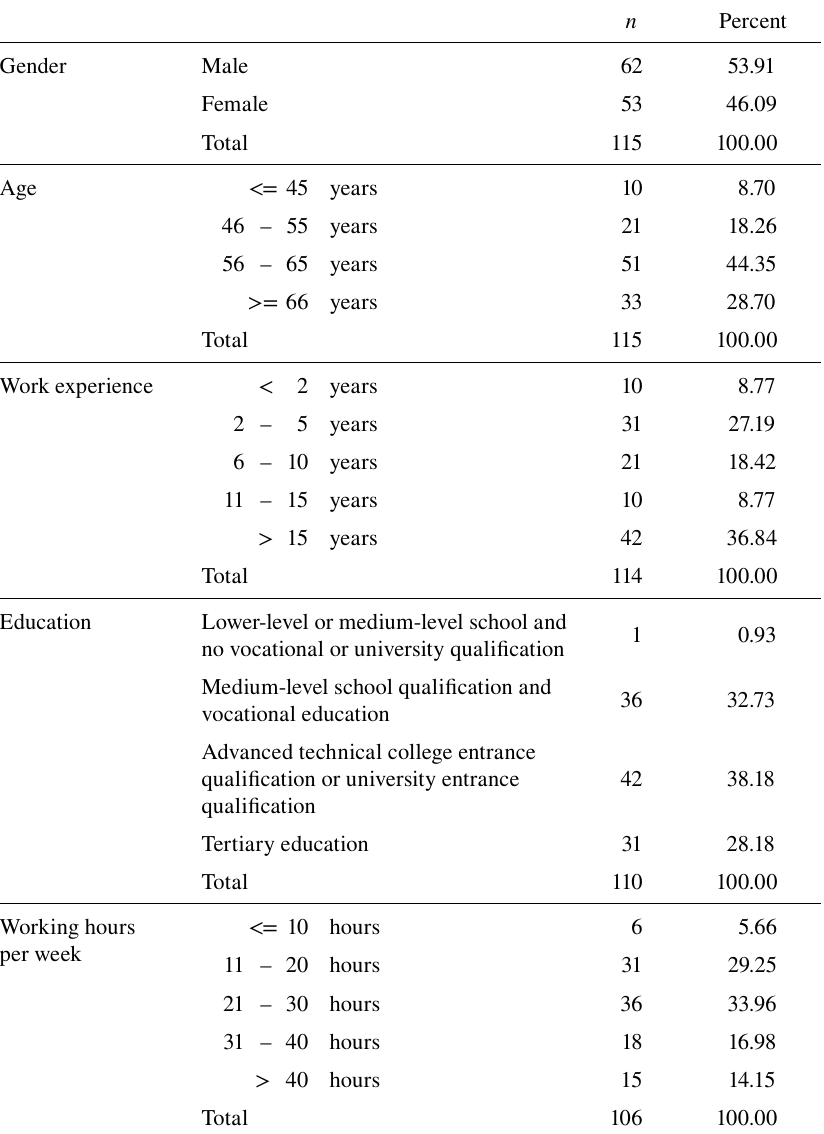
Table 2 Characteristics of the German PIAAC